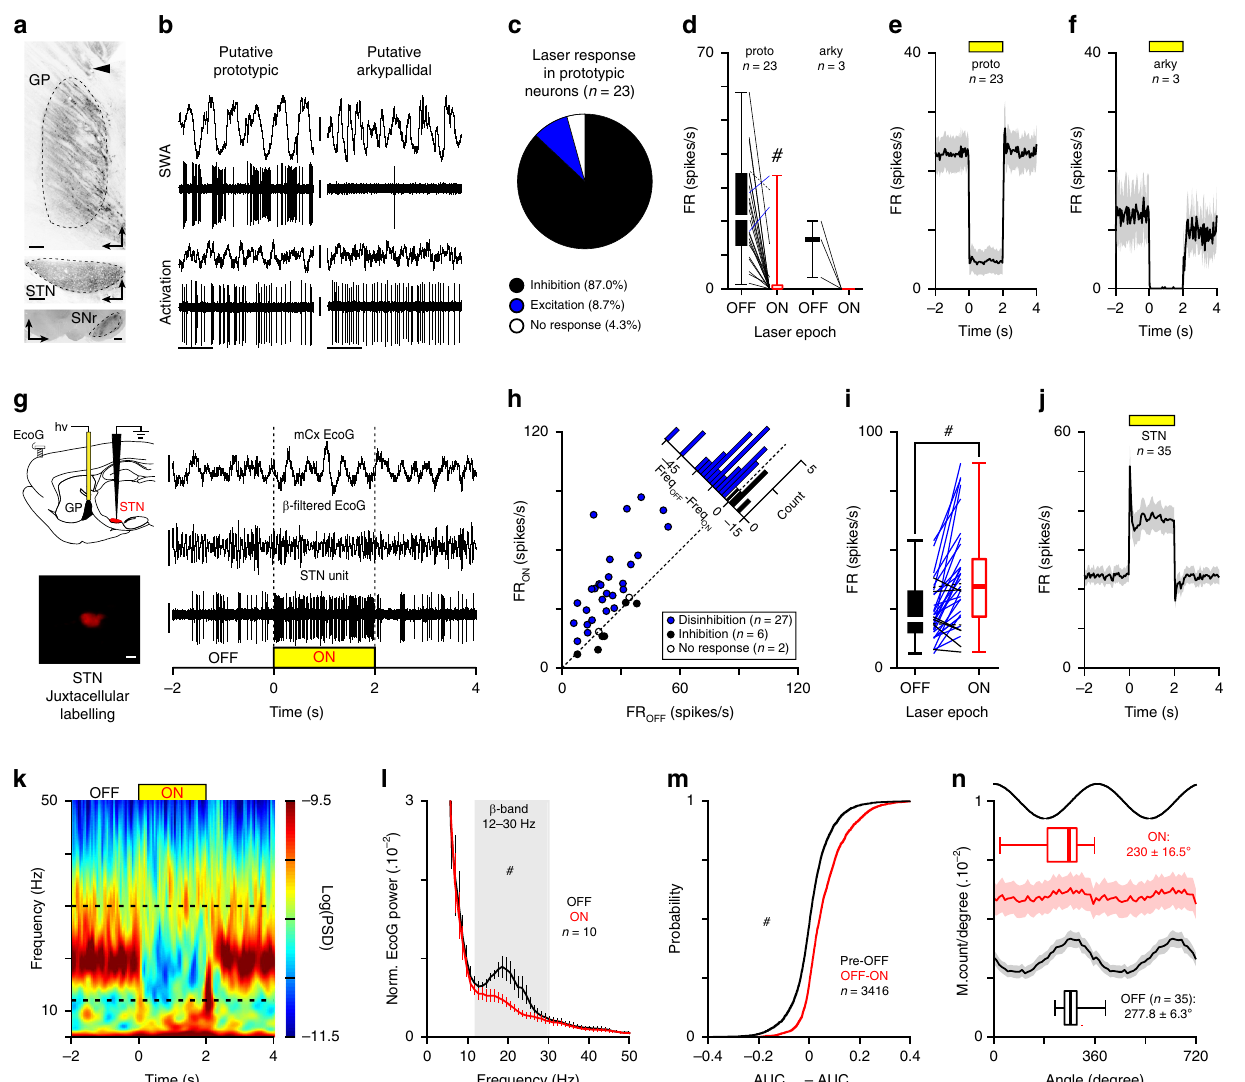
Fig. 4 Globus pallidus opto-inhibition suppresses parkinsonian abnormal β -synchronization in cortico-BG loop. a Epi fl uorescence images showing the eArch3-EYFP labeling in GP of 6-OHDA rats (top, scale: 200 µ m, arrowhead indicates the optic fi ber track) and dense axonal labeling in STN (middle, scale: 200 µ m) and SNr (bottom, scale: 500 µ m). b Electrophysiological activity of prototypic and arkypallidal neurons during SWA (top) and global activation (bottom). ECoG scale: 0.2 mV; spike unit: 0.5 mV. c Proportion of GP neurons inhibited (black), excited (blue), or not modulated (white) by laser stimulation. d Effect of opto-inhibition on prototypic and arkypallidal fi ring. Population PSTH of opto-inhibition on prototypic ( e ) and arkypallidal neurons ( f ) (bin: 50 ms). g Experimental paradigm (top left) and representative recordings of ECoG (scales: 250 µ V), β - fi ltered ECoG (12 – 30 Hz, scale: 250 µ V), and one STN unit (scale: 1 mV) during GP opto-inhibition. Example of juxtacellularly labeled STN neuron (bottom left, scale: 20 µ m). h Scatter plot of GP opto-inhibition on STN fi ring. i STN fi ring rate changes during OFF versus ON GP opto-inhibition. j Mean PSTH of STN during laser stimulations (bin: 50 ms). k Peri-event spectrogram of mCx ECoG illustrating the impact of GP opto-inhibition during β -oscillations. l Mean normalized power spectrum of mCx ECoG OFF versus ON GP opto-inhibition (analysis on the best β epochs). m Cumulative distribution function of the β -AUCs differences calculated for AUC (Pre – OFF) versus AUC (OFF – ON) for all ECoG β epochs during GP opto-inhibition. n Mean phase histograms of STN neurons during β -oscillations OFF versus ON laser epochs. Group data represents mean ± SEM, box-and-whisker plots indicate median, fi rst and third quartile, min and max values. See also Supplementary Table 4 for statistical